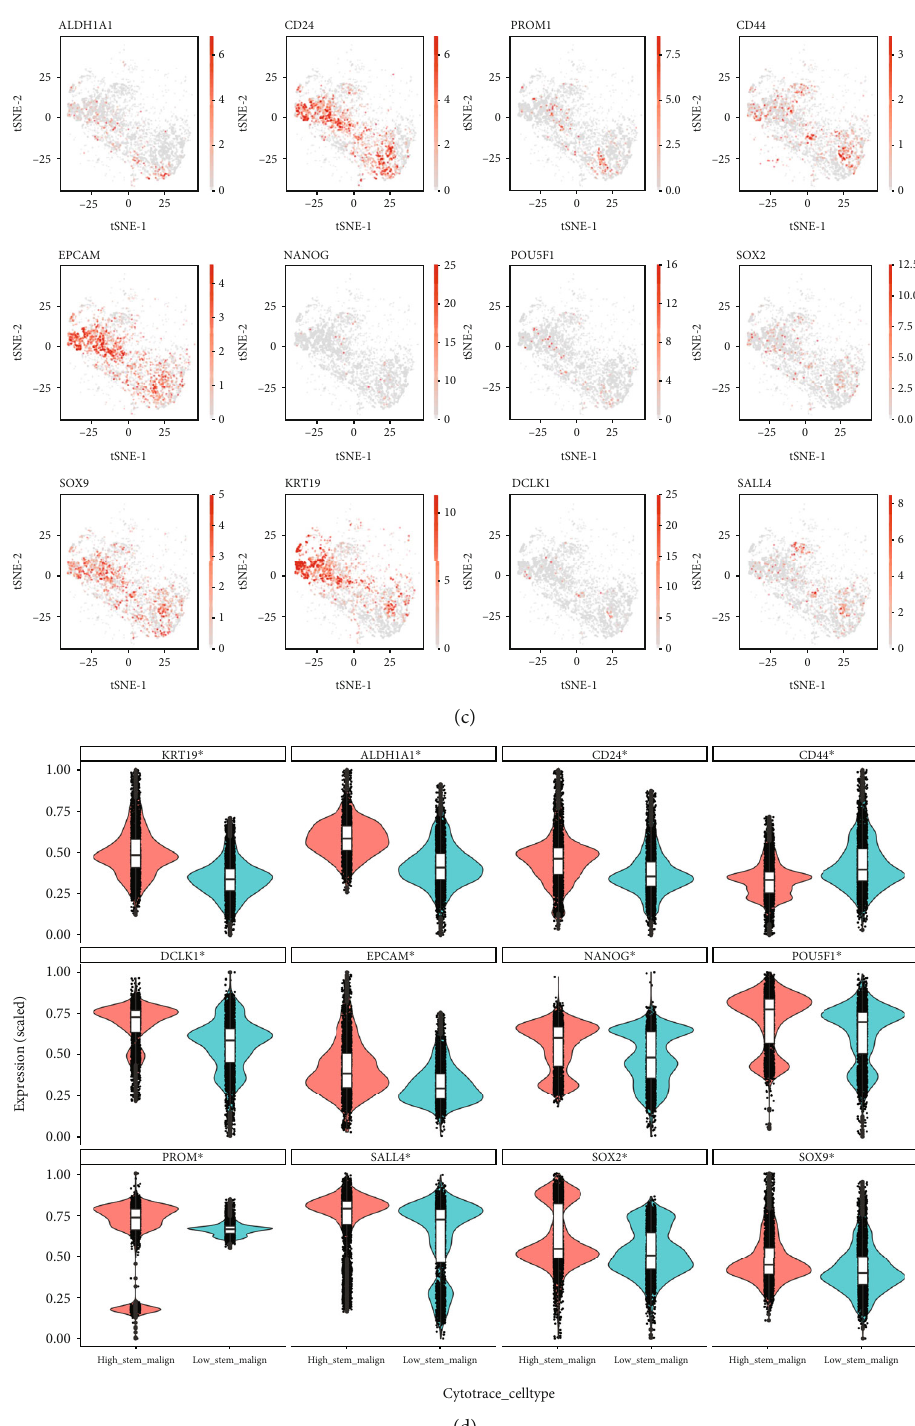
Figure 1: Di ff erentiation heterogeneity of malignant cells in iCCA. (a) tSNE plots for malignant cells from 5 tumor samples (upper panel). CytoTRACE analysis of malignant cells (lower panel). CytoTRACE scores projected with tSNE plots are colored red to indicate high stemness/low di ff erentiation and blue for low stemness/high di ff erentiation. (b) GSEA enrichment and leading-edge plots. (Top) Di ff erentially expressed genes found in CytoTRACE classi fi ed high stemness malignant cells and low stemness malignant cells. Genes were ranked by Log2FC. (Bottom) Genes contributing the most to the enrichment score. The top 10 genes that are predicted to be speci fi cally associated with high stemness malignant cells are indicated on the right box. (c) tSNE plots showing the expression of CSC marker genes. (d) Violin plots showing the expression of CSC marker genes. ∗ indicates P < 0 : 05